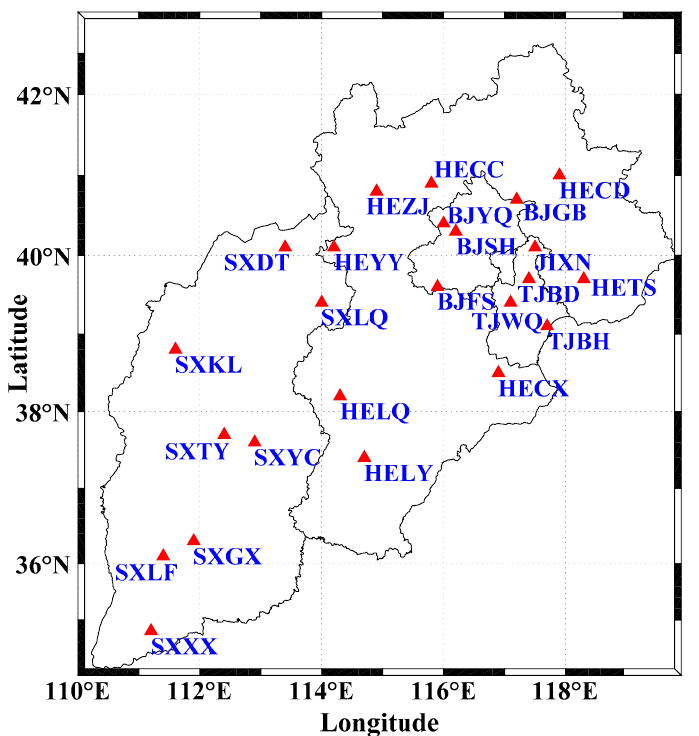
Figure 1. Distribution of 24 global navigation satellite system (GNSS) stations in North China.